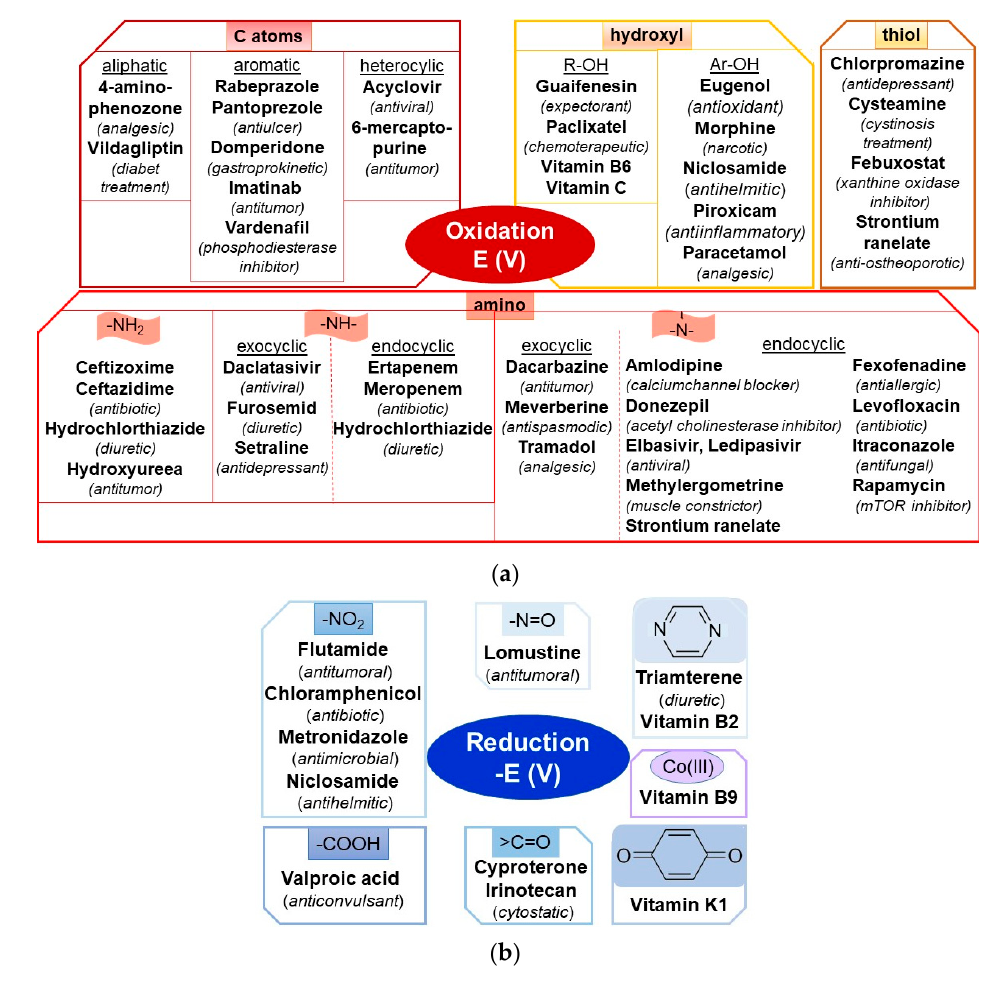
Figure 2. Examples of electroactive sites generating the ( a ) anodic and ( b ) cathodic signals employed for the voltametric analysis of the corresponding pharmaceuticals.